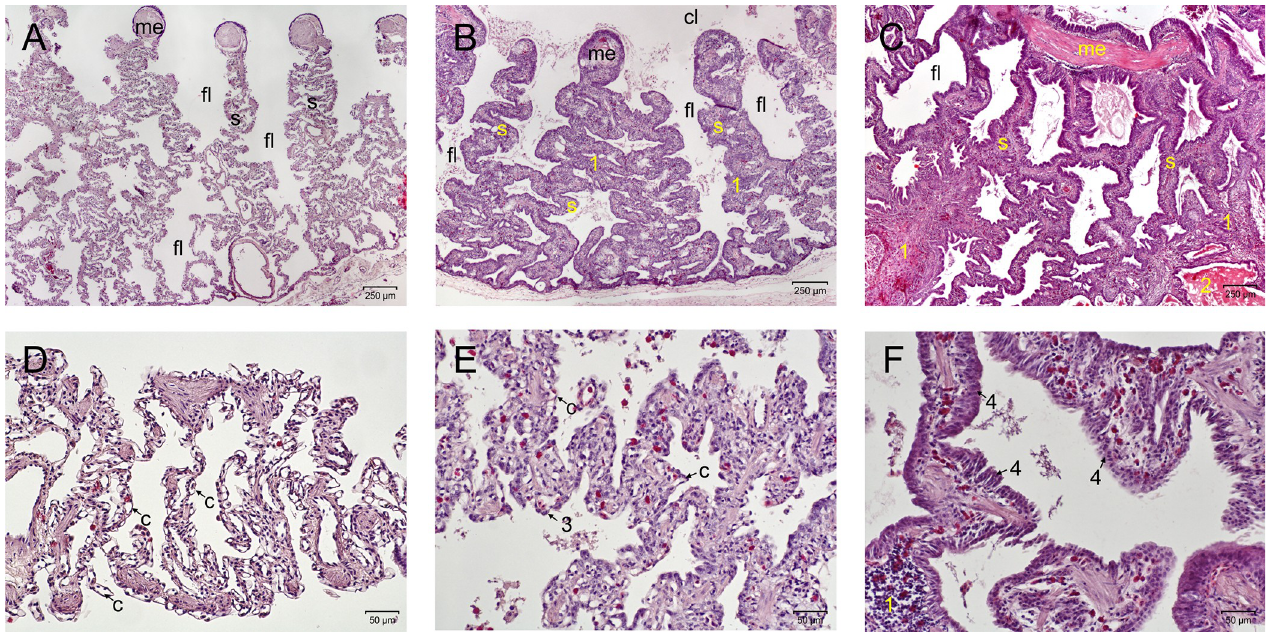
Fig 6. Sections of the lung, light microscopy, H&E stain, A-C: 40x magnification; D-F: 200x magnification, day post infectionem. (A,D) Score 0, snake No. P1, day 49. Demonstration of a cross section through an unremarkable lung. The myoelastic inner border of the lung tissue and faveoli lead to the respiratory tissue along the septae. Capillaries are bulging into the air spaces, demonstrating a thin air-blood-barrier. (B,E) Score 1, snake No. A4, day 16. Demonstration of a cross section through a ferlavirus infected lung, moderate changes. The septae appear thickened and initial transformation of the lung epithelium can be seen. Capillaries are still close to the surface, but the epithelial cells are starting to transform (3). Infiltration of lymphocytes and plasma cells in the septae (1). (C,F) Score 2, snake No. B11, day 35. Demonstration of a cross section (not complete) through a severely affected lung. The septae are massively thickened, the faveoli narrowed and partially filled with debris (2). Massive thickening and infiltration of heterophils, lymphocytes and plasma cells in the interstitium (1), transformation of the respiratory epithelium into a multilayered epithelium (4). (c–capillary; cl–central lumen; fl–faveolus; me— myoelastic tissue; s—septum).